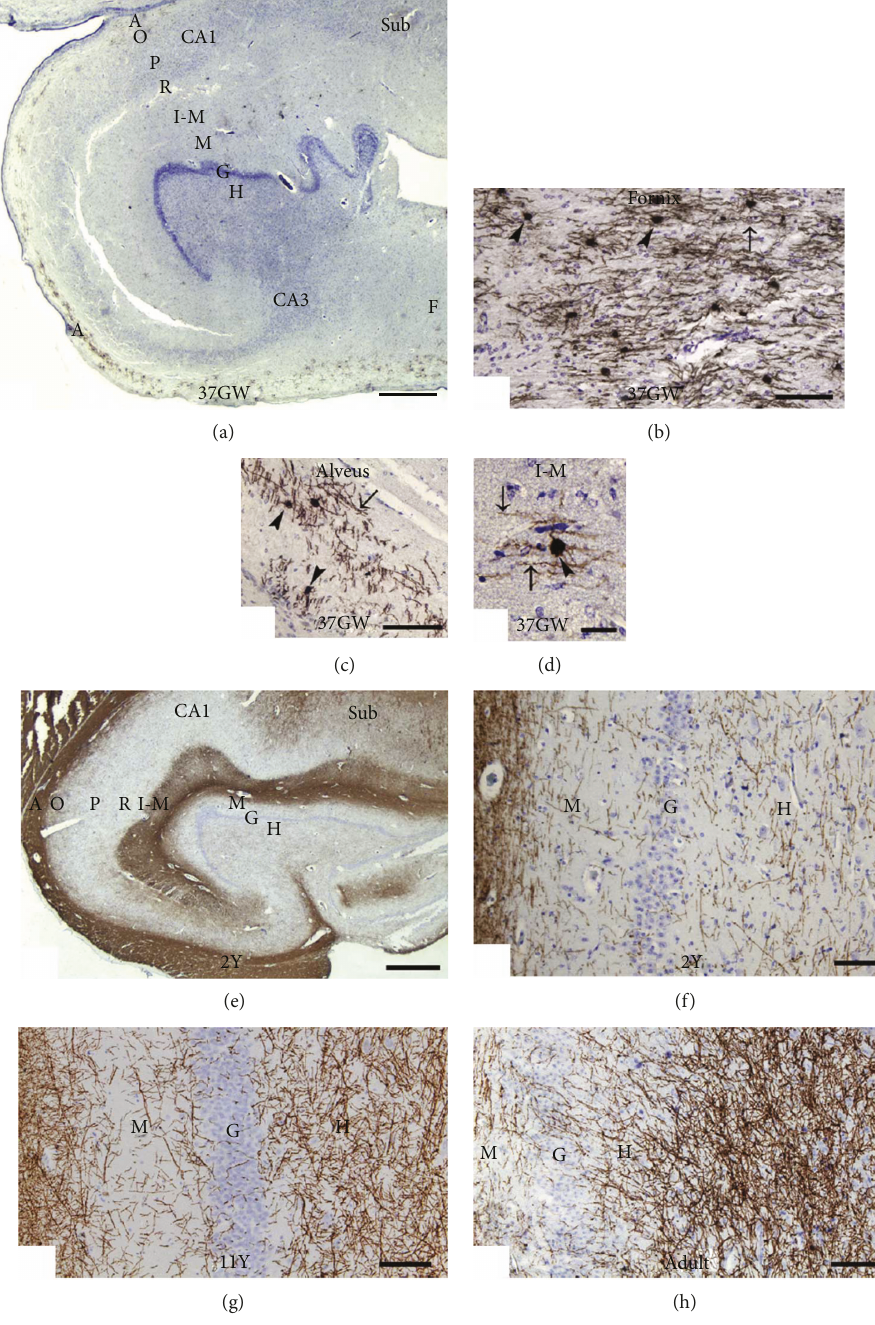
Figure 1: Myelin formation in the hippocampus of humans at di ff erent developmental stages. (a) At the 37th gestational week (GW), MBP- positive myelin segments (brown) are present in the fi mbria (F), in the entire alveus (A), and in the stratum lacunosum-moleculare (L-M) of the CA1 region. MBP-positive OL cell bodies (arrowheads) and myelin segments (arrows) are present in the fi mbria fornicis (b), in the alveus (c), and in the stratum lacunosum-moleculare (L-M) (d) in an infant born at the 37th GW. (e) At 2 years of age, strong MBP staining was observed in the alveus, in the stratum lacunosum-moleculare (L-M) of Ammon ’ s horn, and in the outer half of the molecular layer (M) of the dentate gyrus. MBP-positive myelin segments are also present in the strata oriens (O), pyramidale (P), and radiatum (R) of Ammon ’ s horn. (f) MBP-positive myelin segments in the hilus (H) of dentate gyrus at 2 years of age. (g) MBP-positive myelin segments start to form a dense network in the hilus of the dentate gyrus at the age of 11 years. (h) Much denser network of myelin segments in the hilus of a 53-year-old adult. Scale bars: 1000 μ m in (e), 500 μ m in (a), 250 μ m in (g) and (h), and 100 μ m in (b) – (d) and (f). This fi gure is modi fi ed from Abrahám et al. [31], with copyright permission for reusing the fi gure